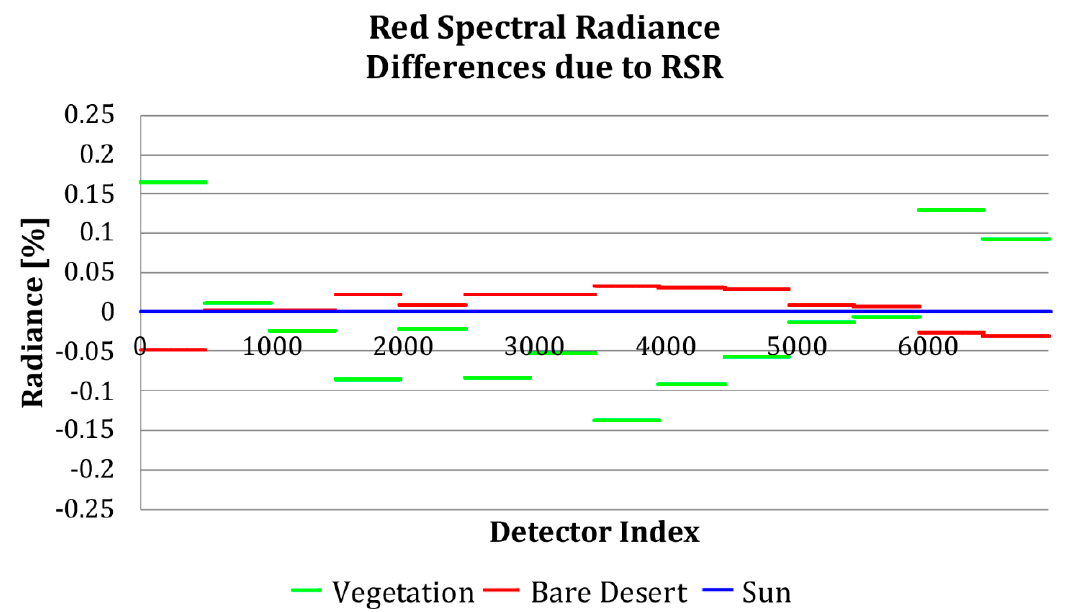
Figure 1. Changes in radiance from a constant sun source that are expected from vegetation and desert targets due to differences in relative spectral response (RSR) across the OLI-2 focal plane.